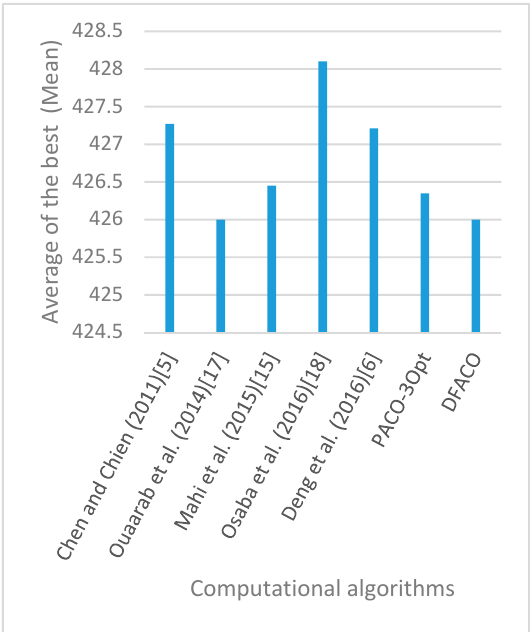
Figure 8. Average of best solutions obtained for instance eil51 by all algorithms.